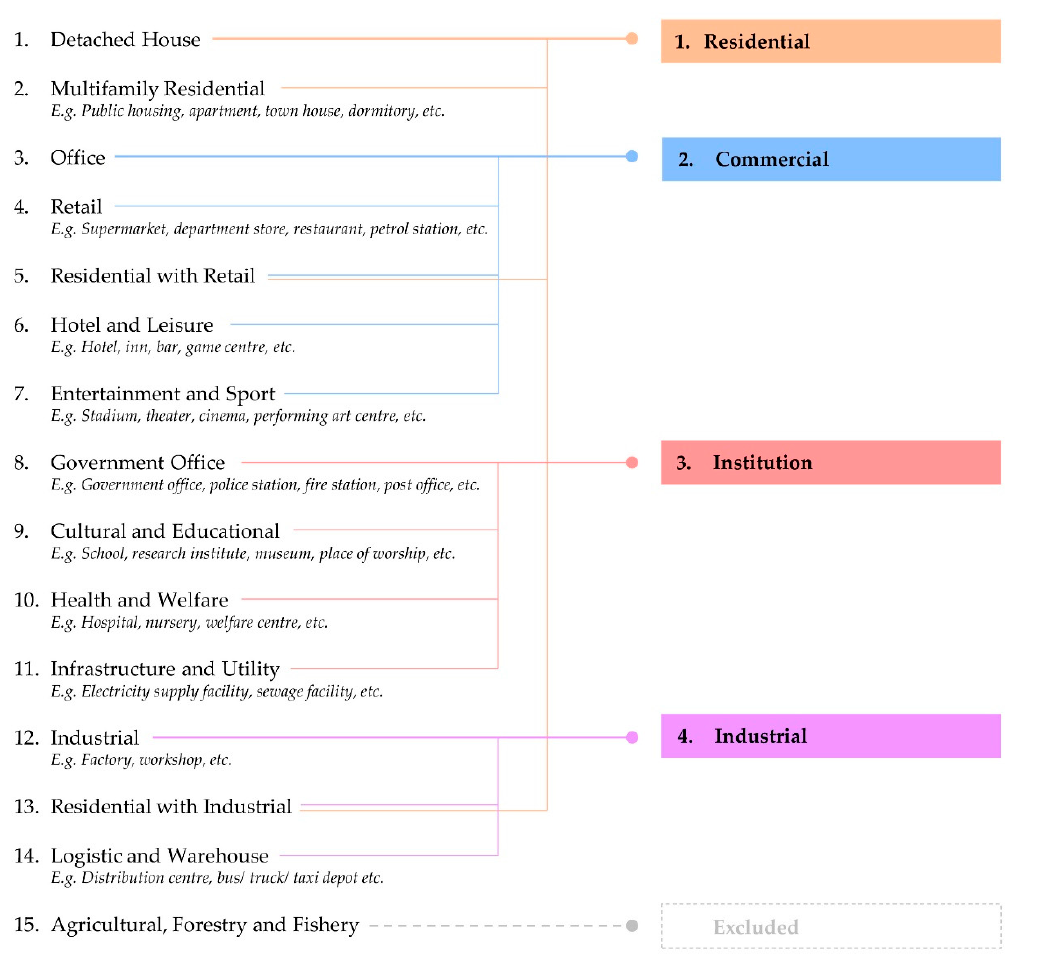
Figure A1. The revised floor space activity category from the administrative building use classification.